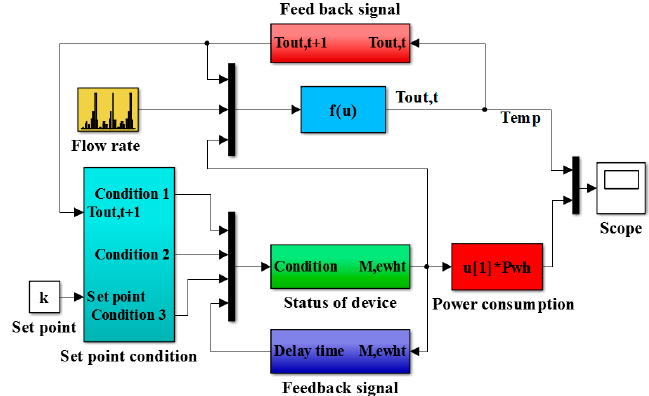
Figure 5. Matlab block for the simulation model of the EWH load model.